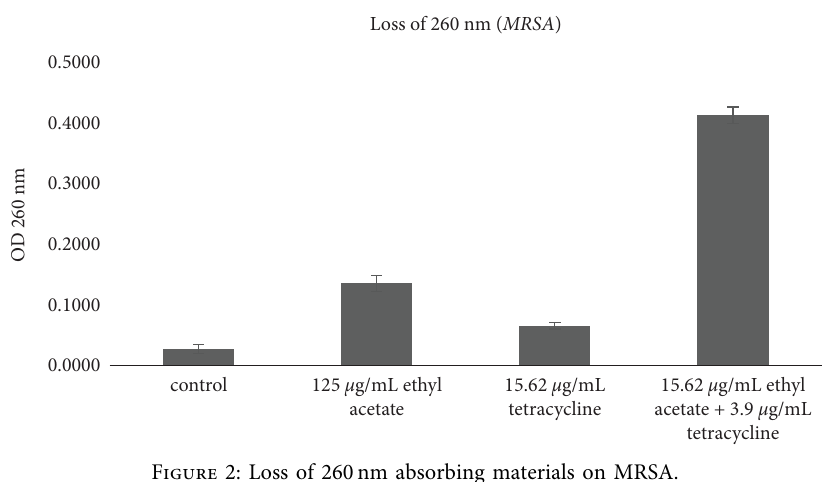
Figure 2: Loss of 260nm absorbing materials on MRSA.